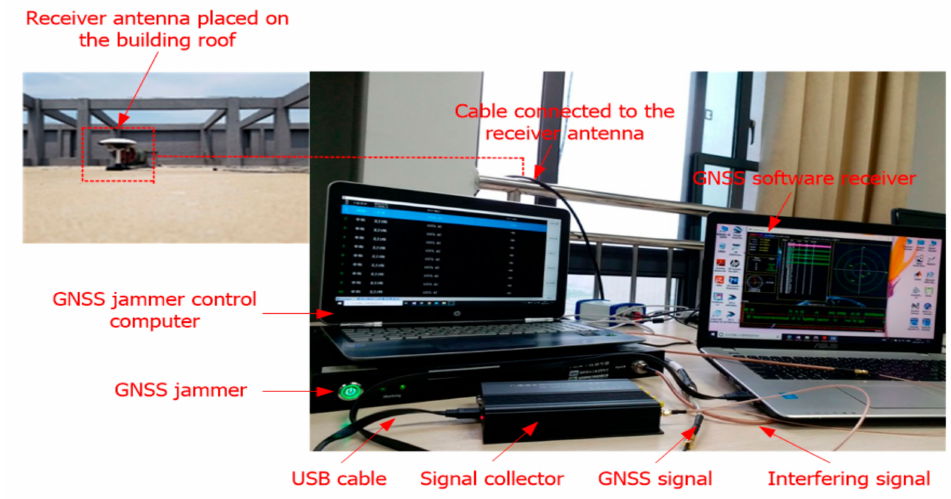
Figure 8. The experimental setup of the GNSS interference detection test.